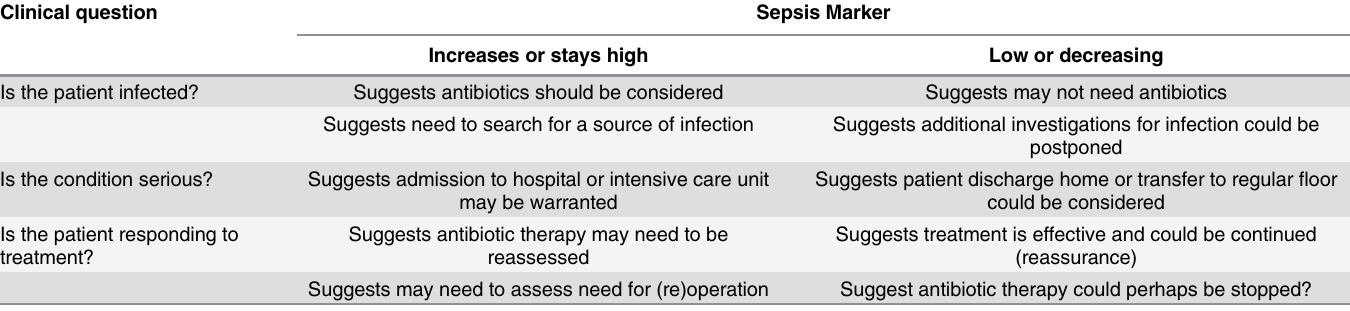
Table 1. How a biomarker, levels of which increase in sepsis, can be used to answer clinically important questions. Clinical